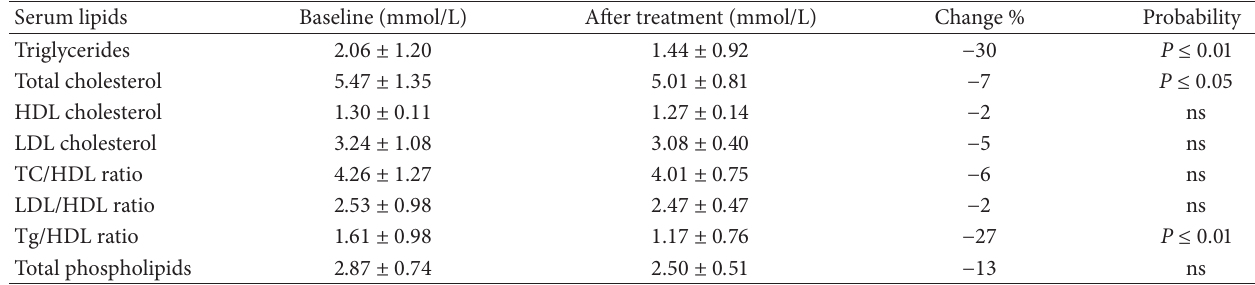
Table 2: Baseline serum lipids profile responsiveness to milled seed mixture after twelve weeks. Serum lipids